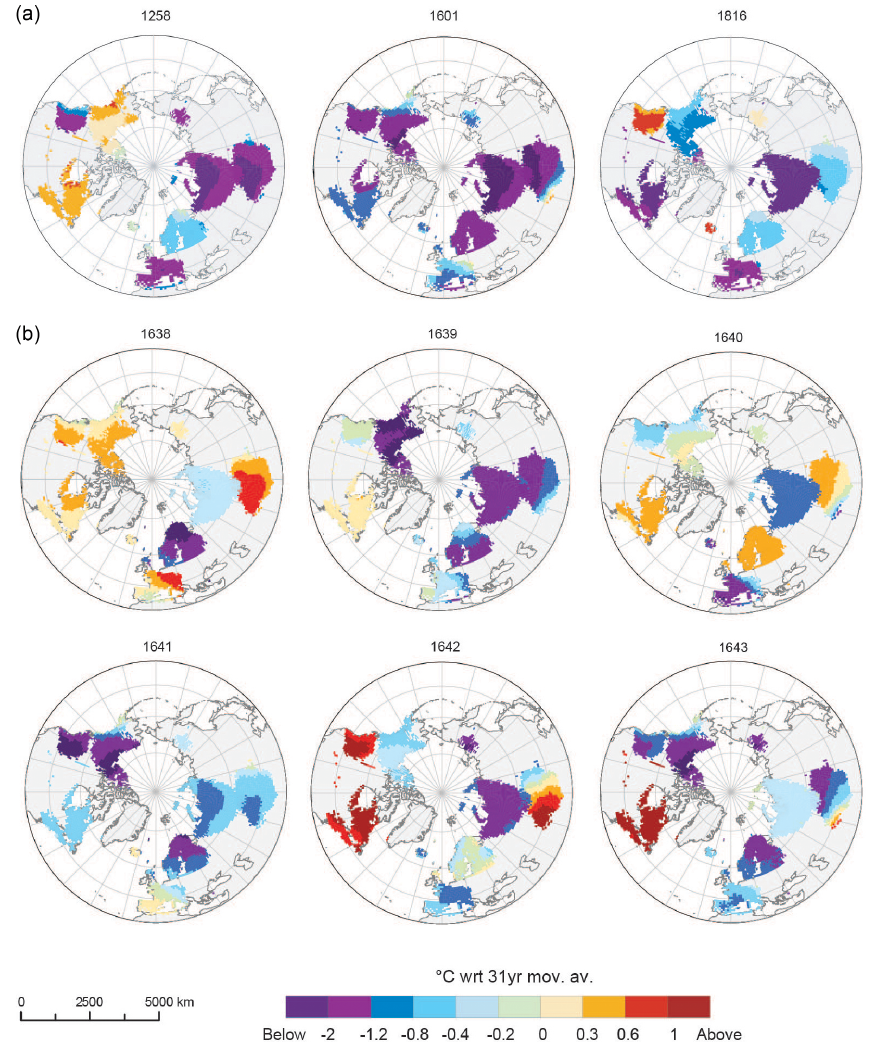
Figure 5. Tree-ring reconstructions of NH extratropical land (40–90 ◦ N) summer temperature (July–August; JJA) anomalies ( NVOLC v2; Guillet et al., 2020) after (a) major volcanic eruptions in 1257 (Samalas), 1600 (Huaynaputina), and 1815 (Tambora) as well as (b) between 1638 and 1643, representing the years before and after the 1640/41 Komaga-take and Mount Parker